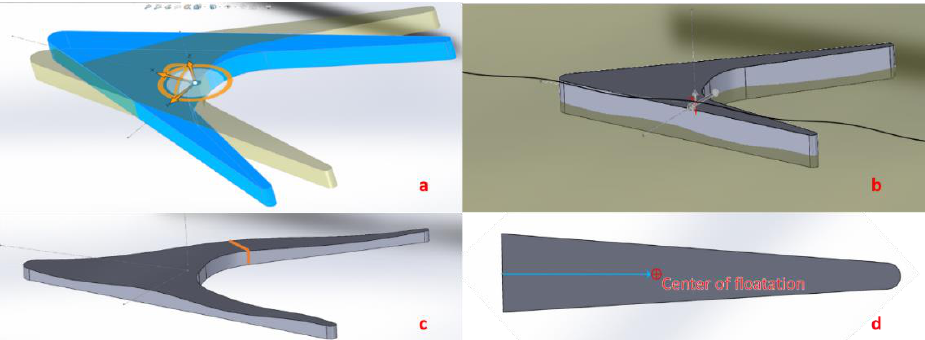
Figure 4. A demonstration of load calculation by CAD: ( a ) positioning the structure at the equilibrium position as calculated by GHS (draft, list, and trim); ( b ) setting the incoming wave surface; ( c ) trimming the solid hull by the wave surface, keeping the underwater part; ( d ) cutting the side-hull at the critical cross section (marked in orange in ( c )) and finding the center of floatation, the moment arm (blue arrow in ( d )), and the volume for the load calculations.